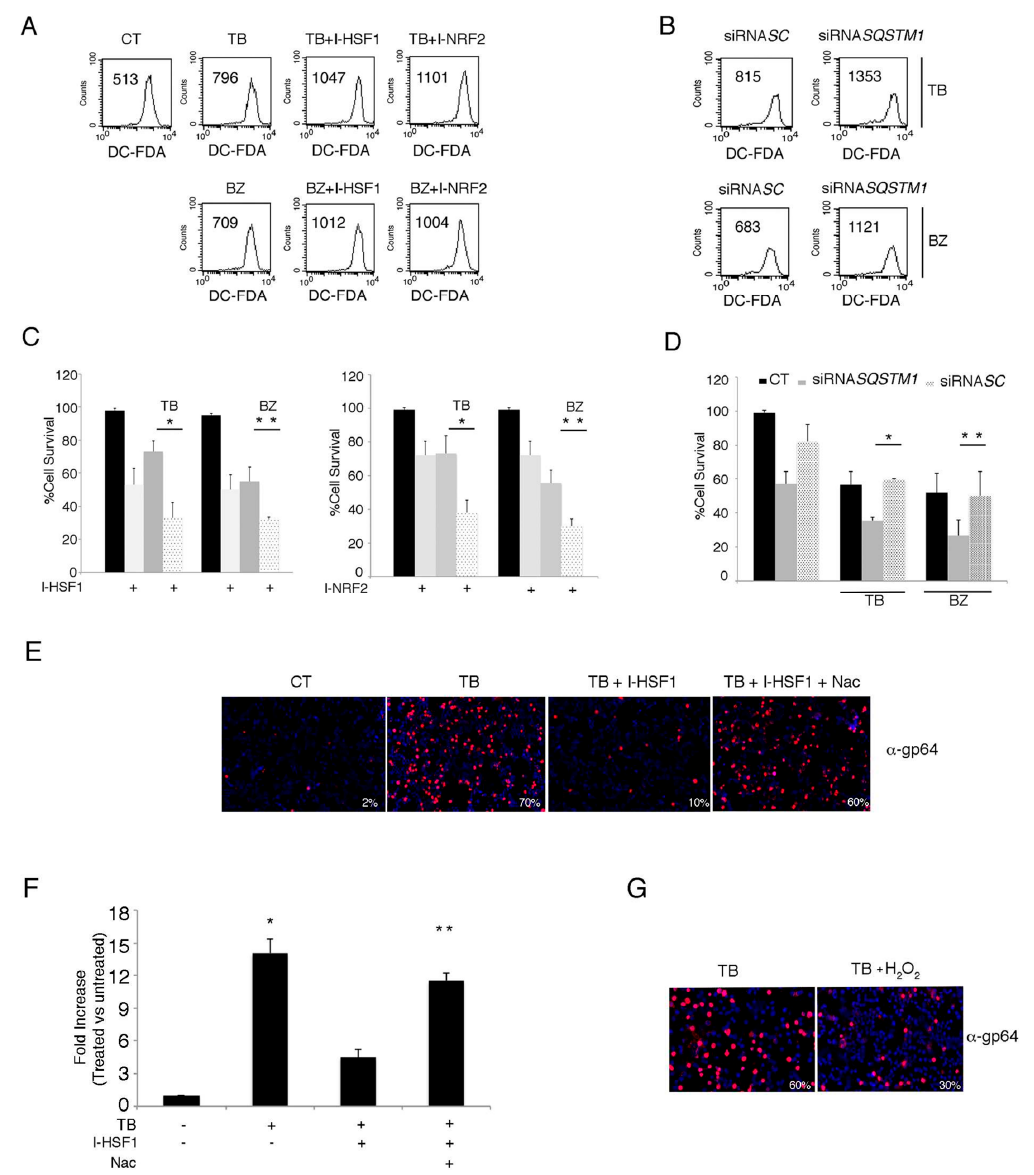
Figure 8. HSF1, NRF2 and SQSTM1 inhibition increases endogenous ROS and decreases PEL cell viability in TB- and BZ-treated PEL cells. ( A ) Intracellular ROS in the BC3 cell line treated with or without HSF1 and NRF2 inhibitors in the presence of TB or BZ. Flow-cytometric analysis was performed to measure ROS using DCFDA staining after 6 h of treatment. The mean of fluorescence intensity is indicated and one representative experiment out of three is shown. ( B ) Intracellular ROS in BC3 cells SQSTM1 knocked-down during treatment with TB or BZ for 6 h. ( C ) Cell viability as evaluated by trypan blue exclusion assay in BC3 cell line treated with TB or BZ, with or without I-HSF1 or I-NRF2 inhibitors for 24 h. Data are plotted as histograms showing mean ± standard deviation (SD). p * < 0.05, p ** < 0.05. ( D ) NRF2 expression in p62/ SQSTM1 knocked-down PEL cells. siRNASC was used as a control. p * < 0.05, p ** < 0.05. ( E ) gp64 expression of PEL cells treated with TB alone or in combination with HSF1 inhibitor in the presence or absence of NAC. Magnification 20 × . ( F ) KSHV release in the supernatants of BC3 cells treated with TB in the presence or absence HSF1 inhibitor and in the presence or absence of NAC. Histograms represent the KSHV DNA fold increase of treated to untreated control cells. The mean ± standard deviation (SD) calculated by statistical software is shown. p * < 0.05, p ** < 0.05. ( G ) gp64 expression of PEL cells treated with TB in the presence or absence of H 2 O 2 . Magnification 20 ×